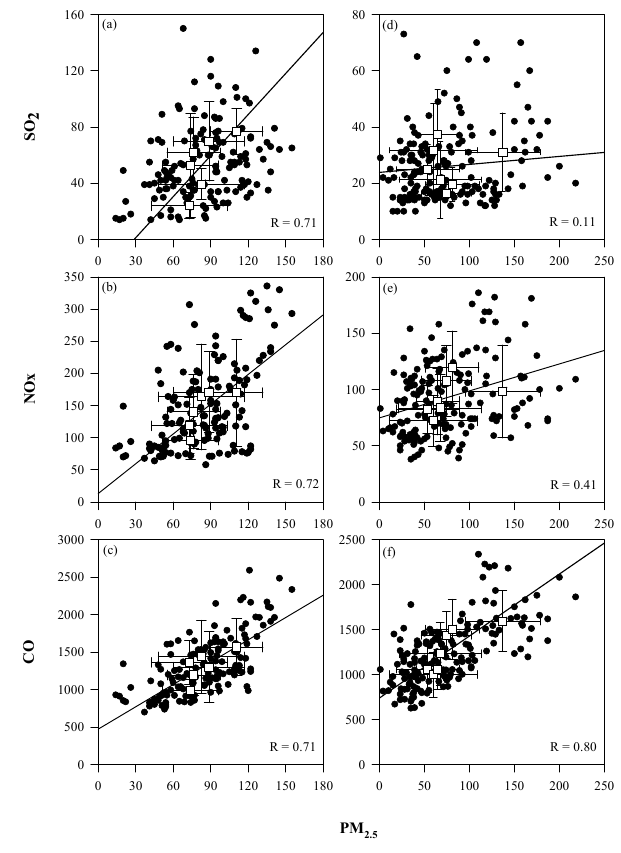
Fig. 12. The linear correlation between gaseous pollutants (SO 2 , NOx and CO) and PM 2.5 , with correlation coefficients (R) shown in the figure. (a) - (c) denote PE1 and (d) - (f) denote PE3. The black dots denote the hourly data and the square symbols denote the daily average data, all units are in μ gm -3 .